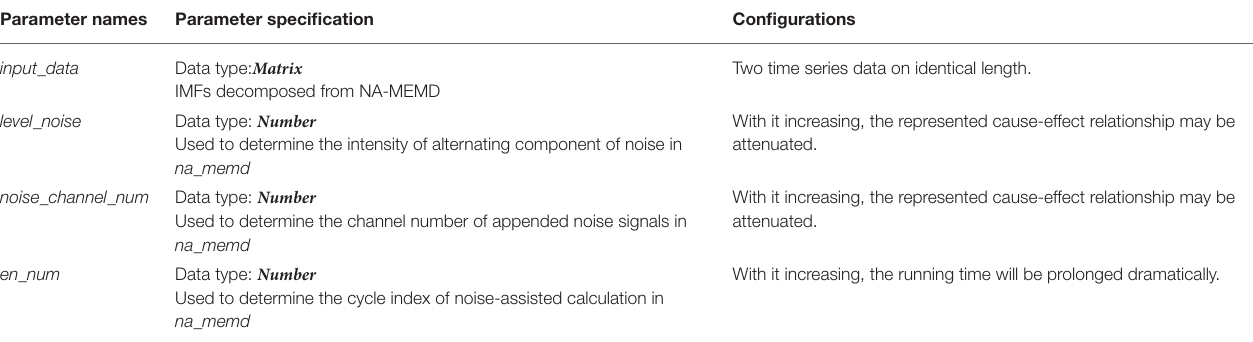
TABLE 2 | Parameter configurations for function PLseries .